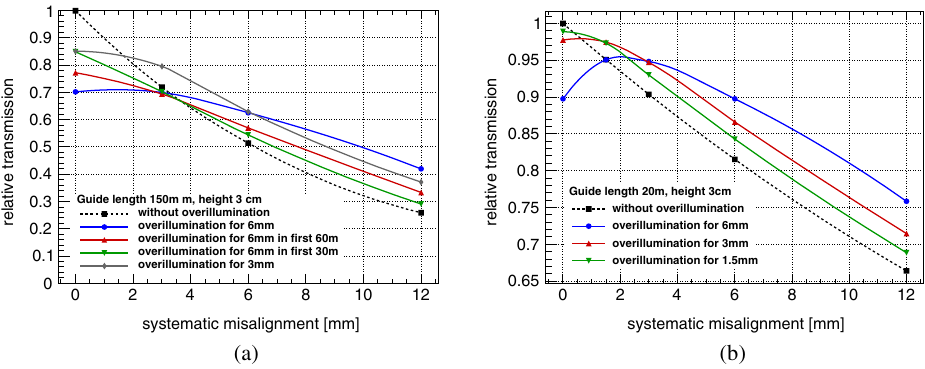
FIG. 3. Relative transmission with respect to perfectly aligned guide, with different amounts of systematic vertical misalignment and overillumination for a certain expected misalignment, 150 m guide (a) and 20 m guide (b) with 1 m long segments. Only systematic